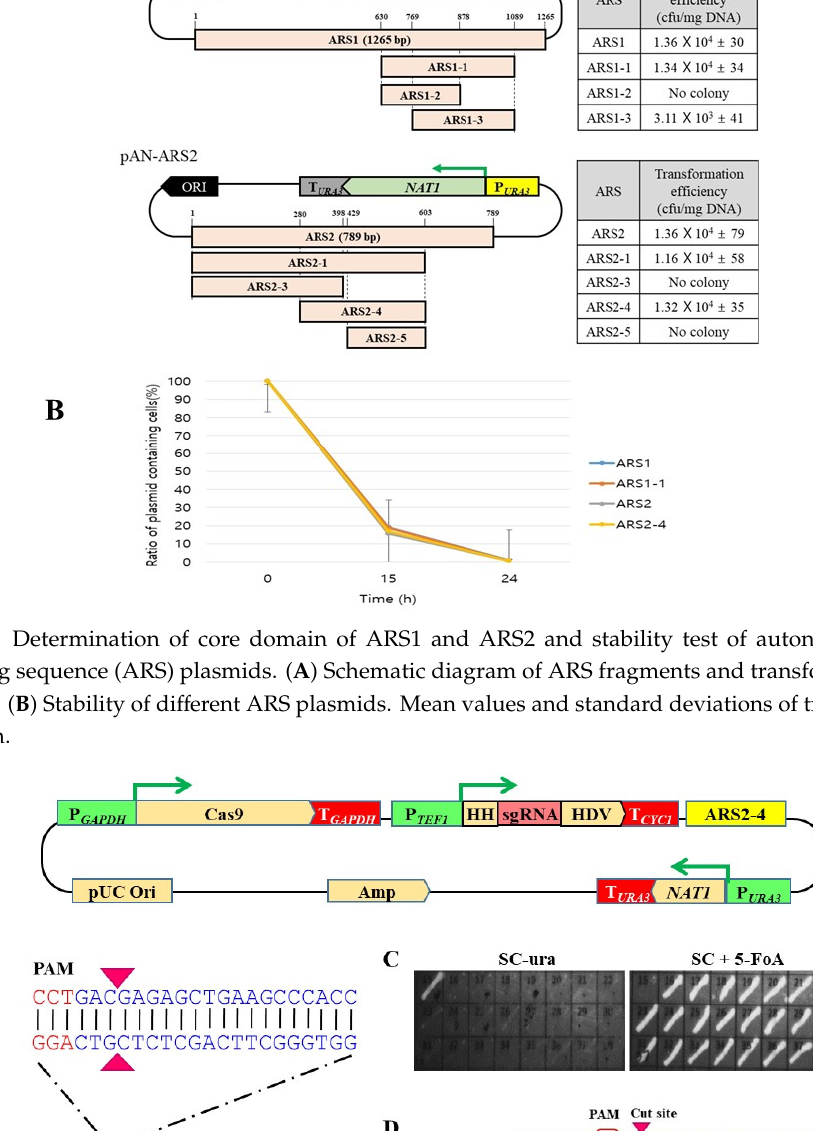
Figure 1. Determination of core domain of ARS1 and ARS2 and stability test of autonomously replicating sequence (ARS) plasmids. ( A ) Schematic diagram of ARS fragments and transformation efficiency. ( B ) Stability of different ARS plasmids. Mean values and standard deviations of triplicates are shown.